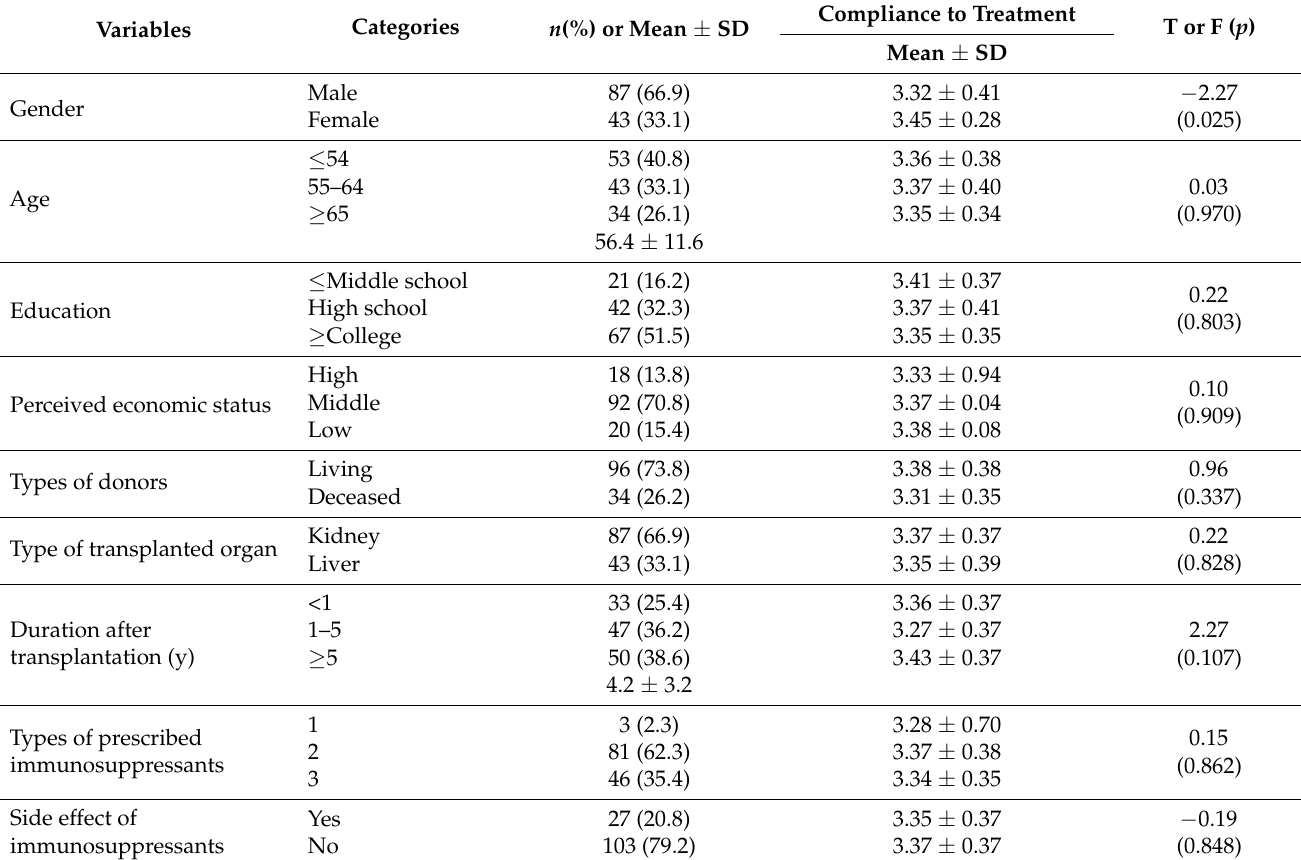
Table 2. Differences of compliance to treatment according to general characteristics ( n =